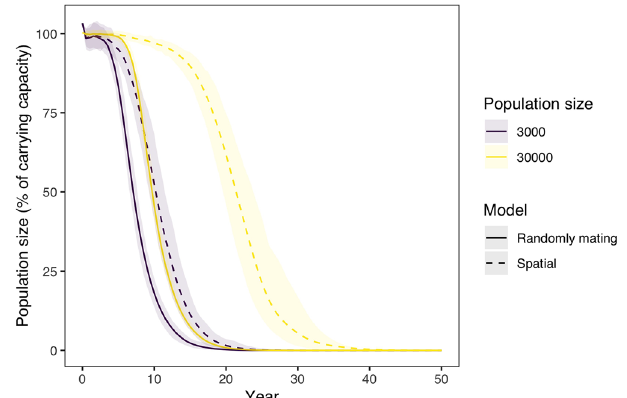
Figure 5. Population size over time after the introduction of 100 squirrels with a homing-cleave-and-rescue gene drive with 1 homing gRNA and 4 cleave-and-rescue gRNAs. The model was run for a randomly mating and a spatial model, and also for a small (carrying capacity 3000) and large population (carrying capacity 30,000). In the spatial model, gene drive squirrels were placed in the middle of the area. An NHEJ rate ( P n ) of 0.02 was used. Lines represent the average population size over 100 model replications, while opaque ribbons represent the 95%